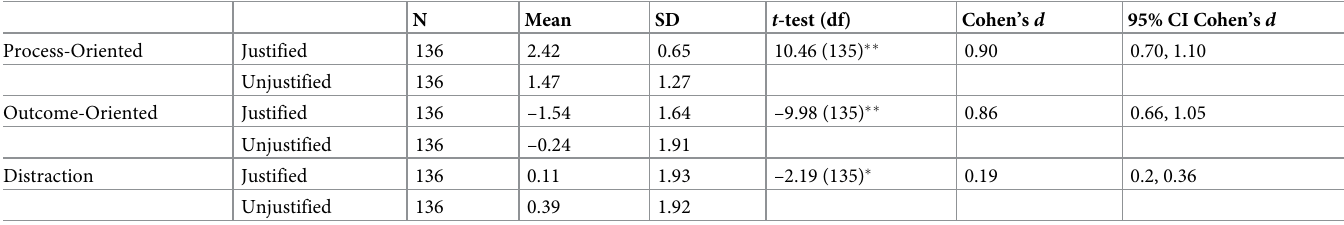
Table 5. T-tests for children’s justified and unjustified negative emotions in relation to caregivers’ behaviors. N Mean SD t- test